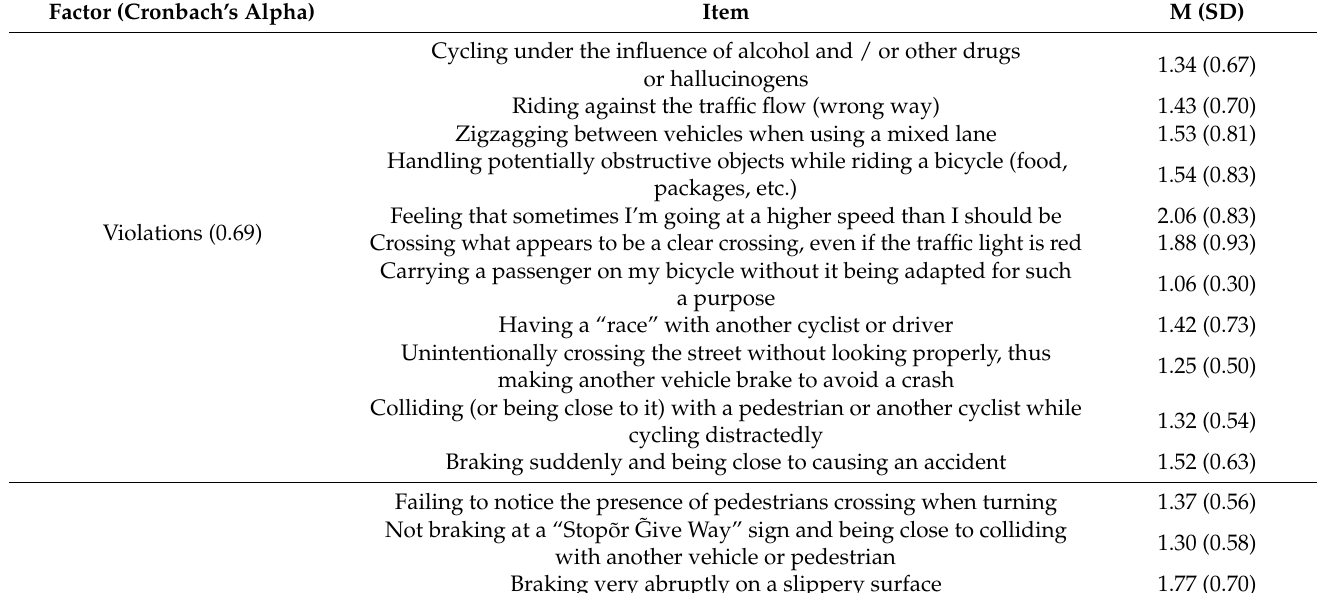
Table 1. Cyclist behaviour questionnaire (CBQ) item scores (scale